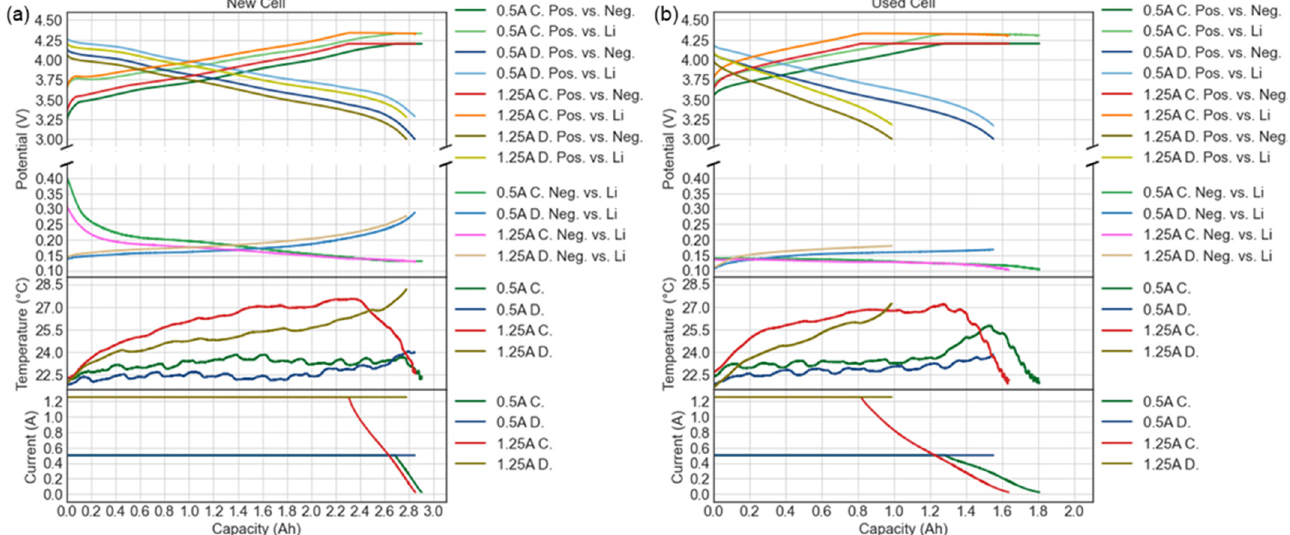
Figure 5. ( a , b ) Voltage, temperature, and current measurement results of new and recycled cells in RE test with one 0.5 A cycle and one 1.25 A cycle. In the legends, “C.” and “D.” represents charge and discharge processes, respectively.